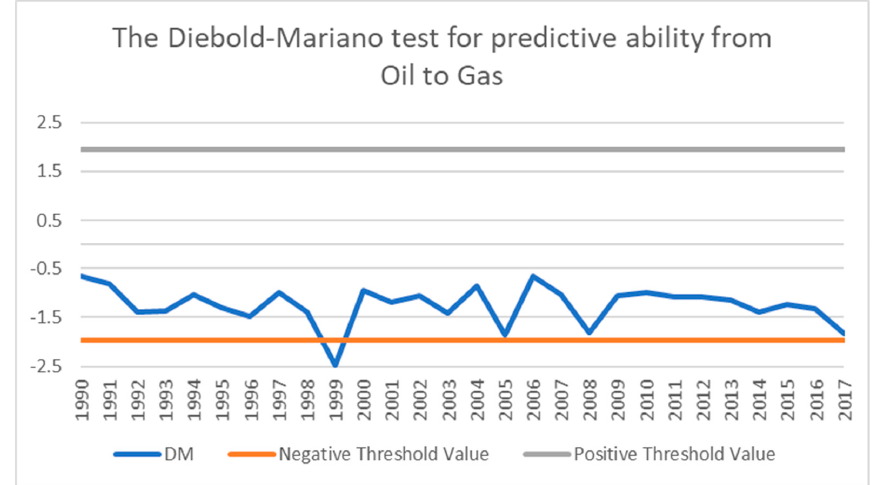
Figure 6. The Diebold-Mariano test for predictive ability from oil to gas.